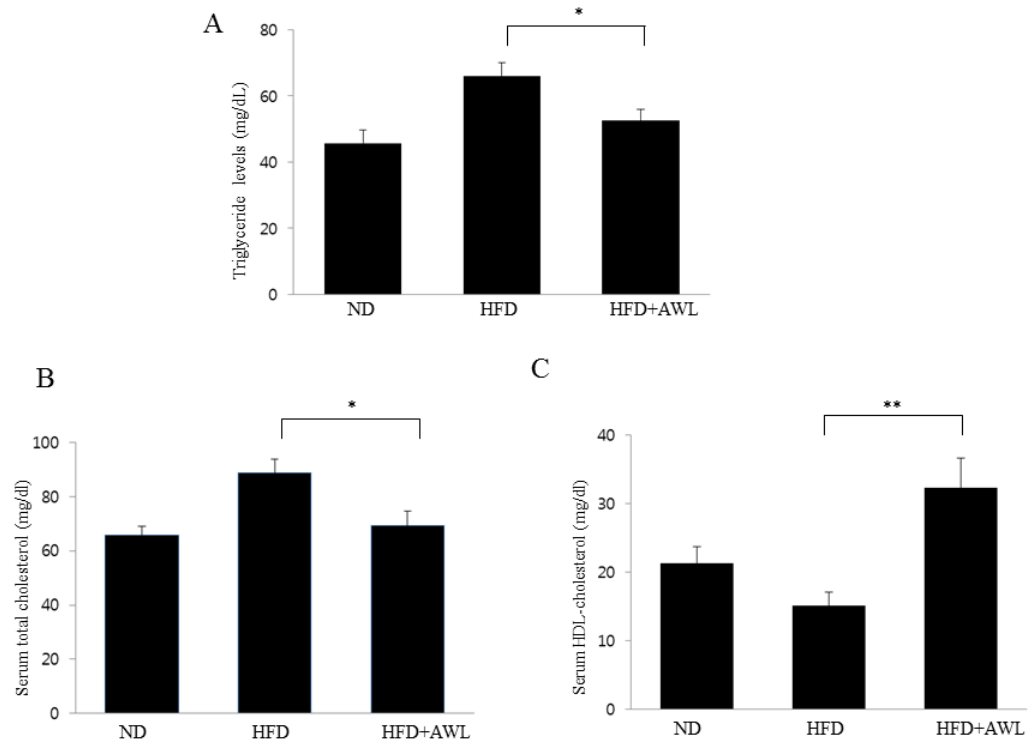
Figure 5. Effects of AWL treatment on lipid content in HFD-induced obese rats. ( A – C ) significant decreases were observed in serum TG and TC levels of the AWL-treated group compared to the HFD alone group. HDL-C levels were significantly higher in the AWL-treated group compared to that in the HFD alone group. Statistical significance between the HFD alone group and HFD plus AWL group was calculated using Duncan’s multiple range test. * p < 0.05, ** p < 0.01.